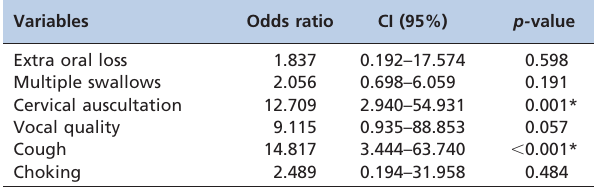
Table 5 - A logistic regression (multivariate analysis) of the independent variables associated with dysphagia